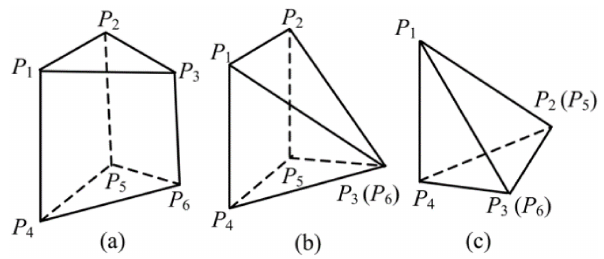
Figure 1. Different GTP elements. (a) The up surface and the down surface of GTP are not necessarily parallel. (b) The edge of P3 and P6 converges to one point. (c) The edge of P2 and P5 also converges to another